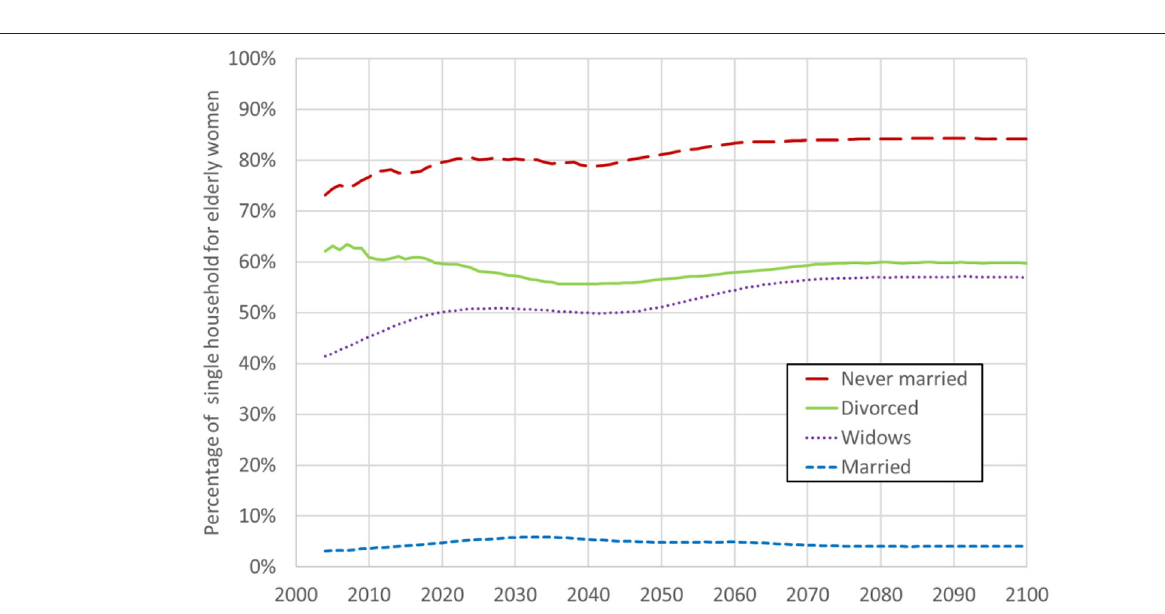
FIGURE 6 | Trends in first quartiles of pension amounts for women by marital status. Simulation results.